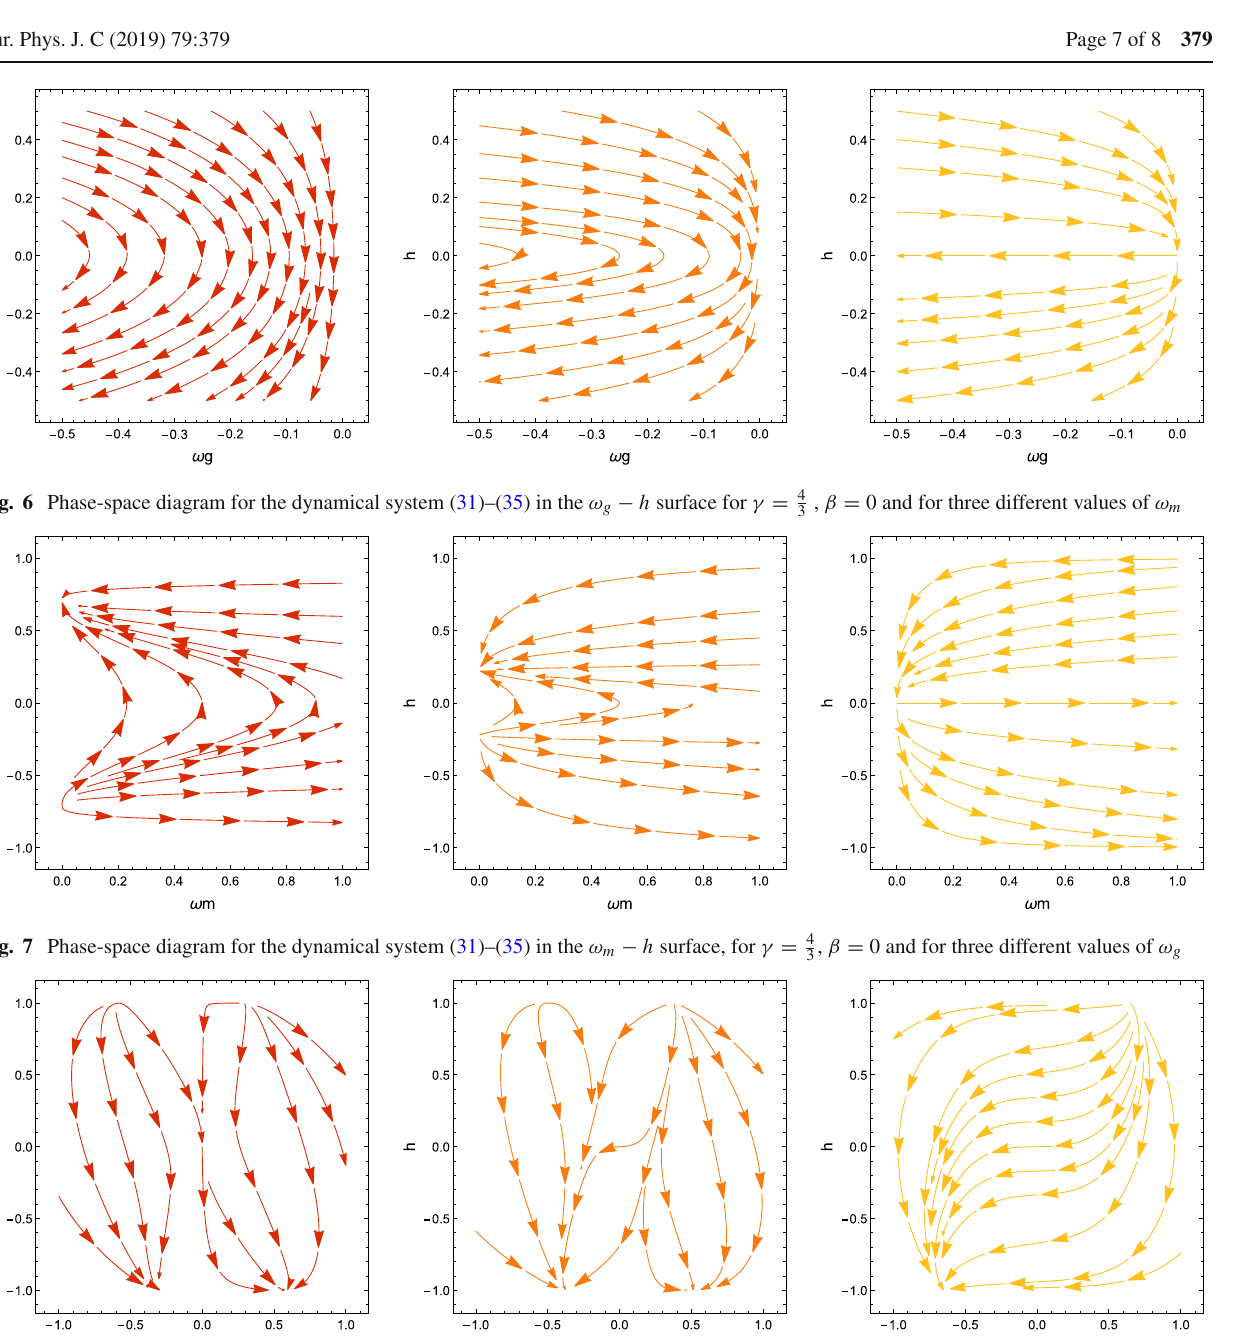
Fig. 8 Phase-space diagram for the dynamical system (31)–(35) in the β − h surface for γ = 4 values of